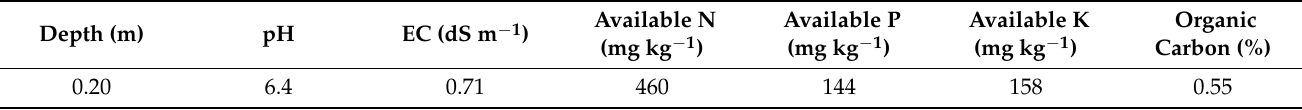
Table 3. Chemical properties of the soil at the experimental